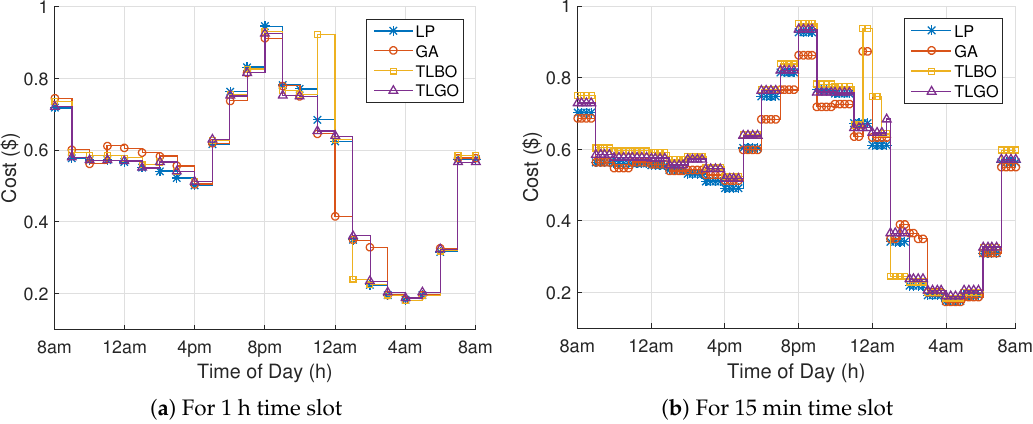
Figure 6. Electricity consumption cost under